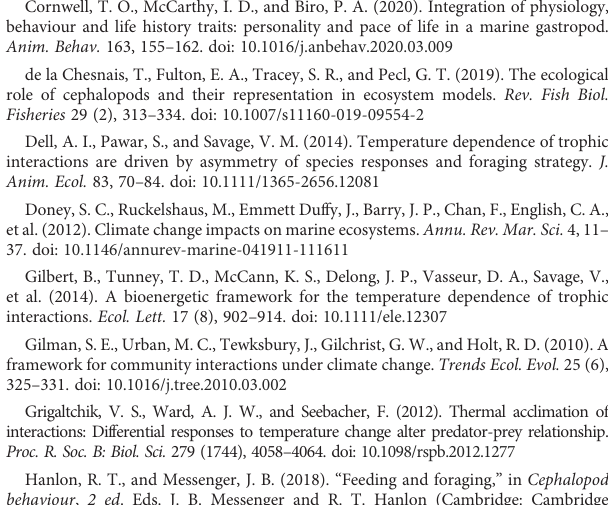
TABLE S.1 Data form this